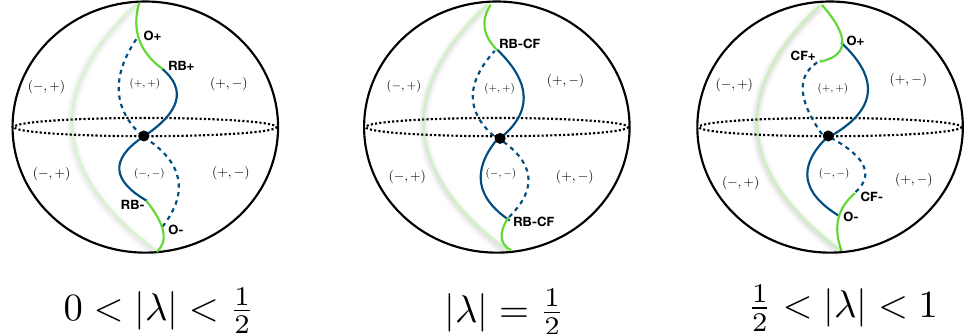
Figure 15. The schematic phase diagram for the N = 2 theory presented in the introduction for three representative values of j (cid:21) j . The black dot on the equator is the CB-RF CFT. The remaining notation is explained in this section (section 4) or in the footnote to (cid:12)gure 1 in the